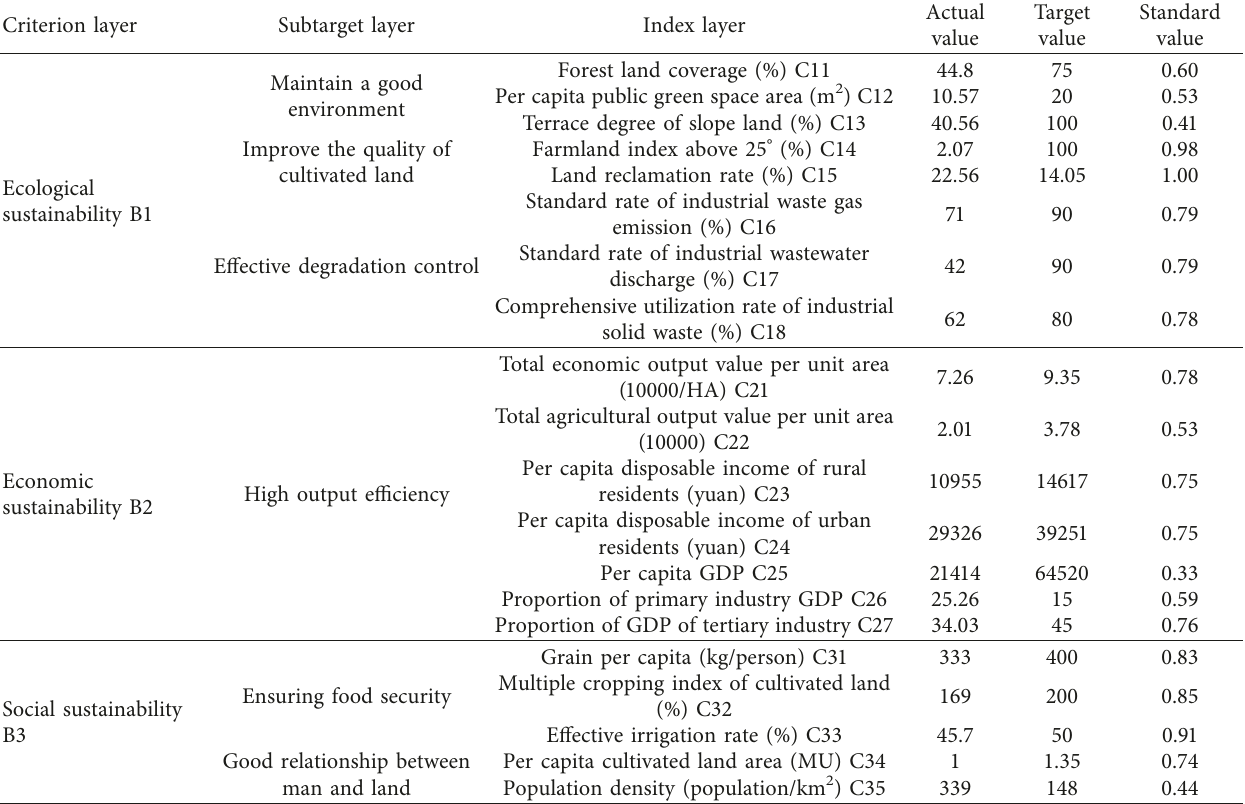
Table 6: Actual value and standard value of evaluation index.